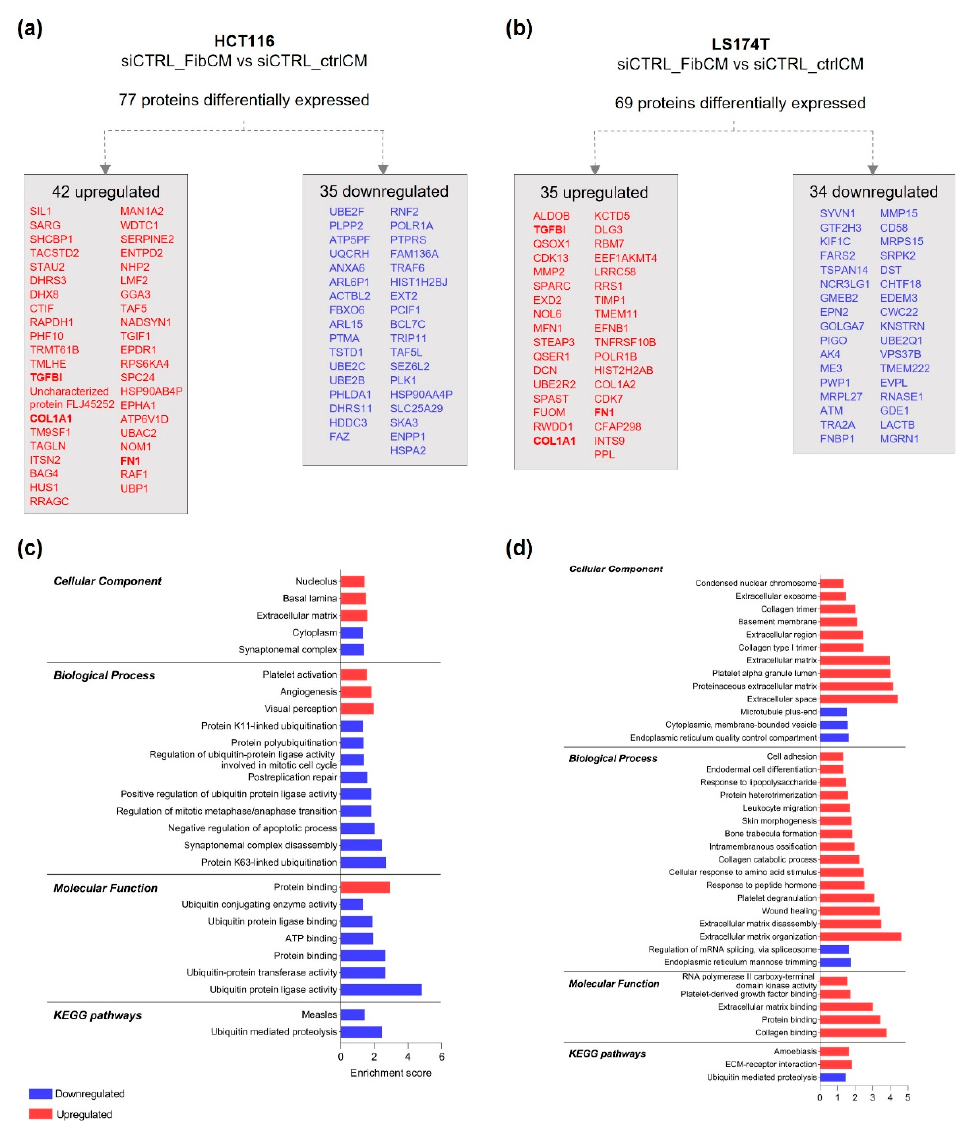
Figure 1. HCT116 and LS174T differentially expressed proteins, upon culture with rhTGF β 1- activated fibroblasts conditioned medium. Significantly up and downregulated proteins in HCT116 ( a ) and LS174T ( b ) siCTRL cells cultured with FibCM (siCTRL_FibCM vs. siCTRL_ctrlCM). Protein lists are organized according to the abundance ratio and common proteins to HCT116 and LS174T cells are highlighted in bold (TGFBI, COL1A1, FN1). GO and KEGG pathways analysis of up and downregulated proteins in HCT116 ( c ) and LS174T ( d ). The enrichment score was calculated by—log p -value. Interestingly, GO analysis revealed that HCT116 and LS174T cells treated with FibCM overexpressed common proteins associated with the extracellular matrix, namely: Collagen Type I Alpha 1 (COL1A1), Fibronectin (FN1), and Transforming Growth Factor Beta Induced protein (TGFBI) (Figure 1a,b). Likewise, KEGG analysis revealed that both cell